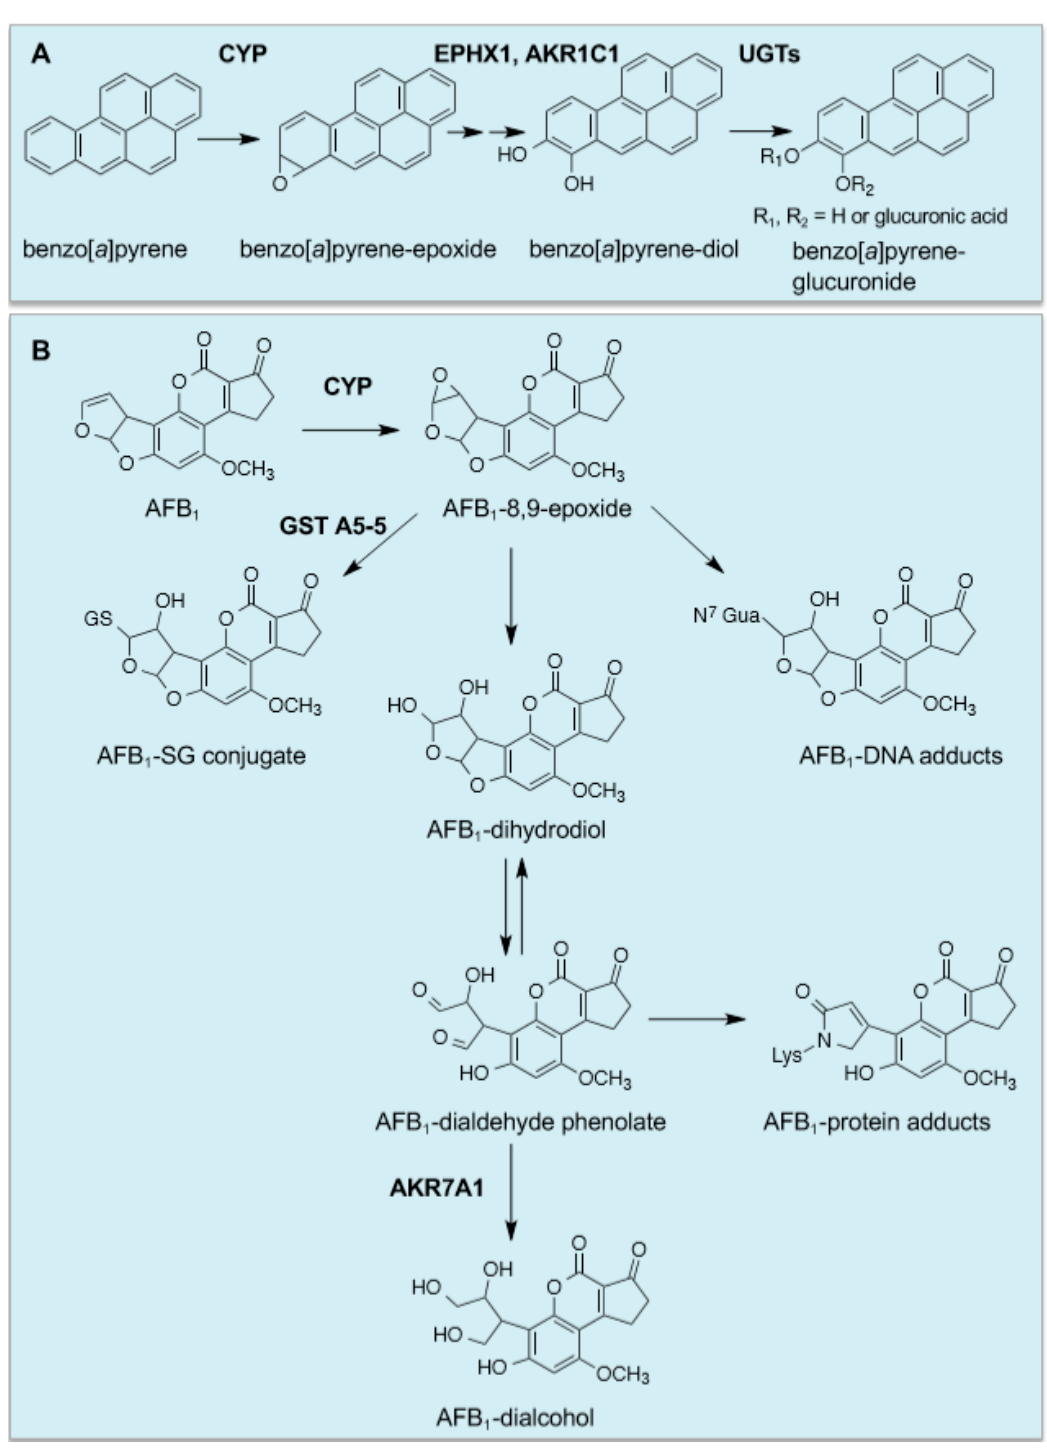
Figure 2. Chemopreventive agents stimulate the metabolic inactivation of chemical carcinogens. The cytochrome P450 (CYP)-catalysed activation of benzo[ a ]pyrene to the epoxidated ultimate carcinogen and its metabolism by EPHX1, AKR1C1 and UGTs is shown in panel ( A ). The CYP-catalysed activation of aflatoxin B 1 to the epoxidated ultimate carcinogen and its metabolism by GST A5-5 and AKR7A1 is shown in panel ( B ).